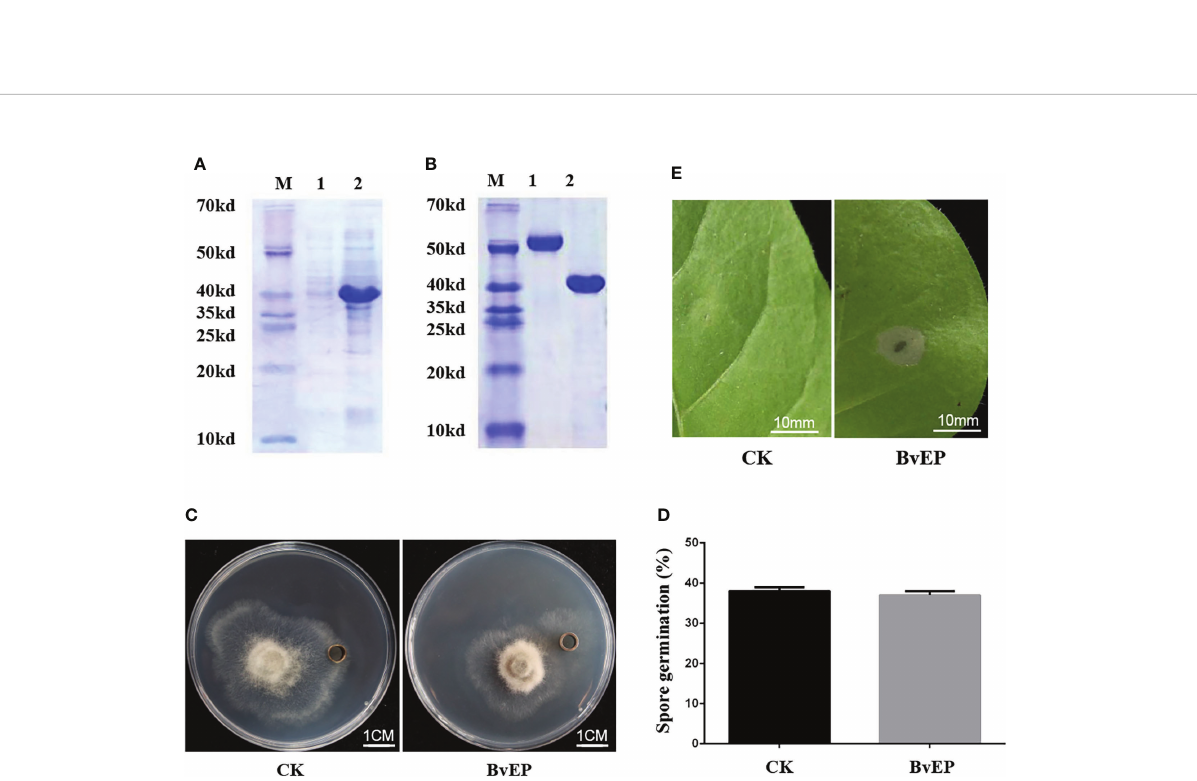
FIGURE 3 Inhibitory effect of BvEP protein on B. cinerea and HR induction in Nicotiana tabacum . (A) SDS-page gel image of the protein after BvEP expression, 1 and 2 are BvEP before and after IPTG induction respectively; (B) SDS-page gel image of BvEP protein after puri fi cation, 1 and 2 are 1.50 m g BSA and puri fi ed BvEP protein respectively; (C) Inhibition experiment of BvEP on B. cinerea in vitro ; Figures CK and BvEP are Tris buffer and 50 m g·mL -1 BvEP protein in oxford cup, respectively; (D) Effects of BvEP puri fi ed protein on spore germination of B. cinerea . (E) BvEP protein HR assay; HR of BvEP on Nicotiana tabacum ; CK and BvEP indicate in fi ltration of Tris buffer and 50 m g·mL -1 BvEP protein,